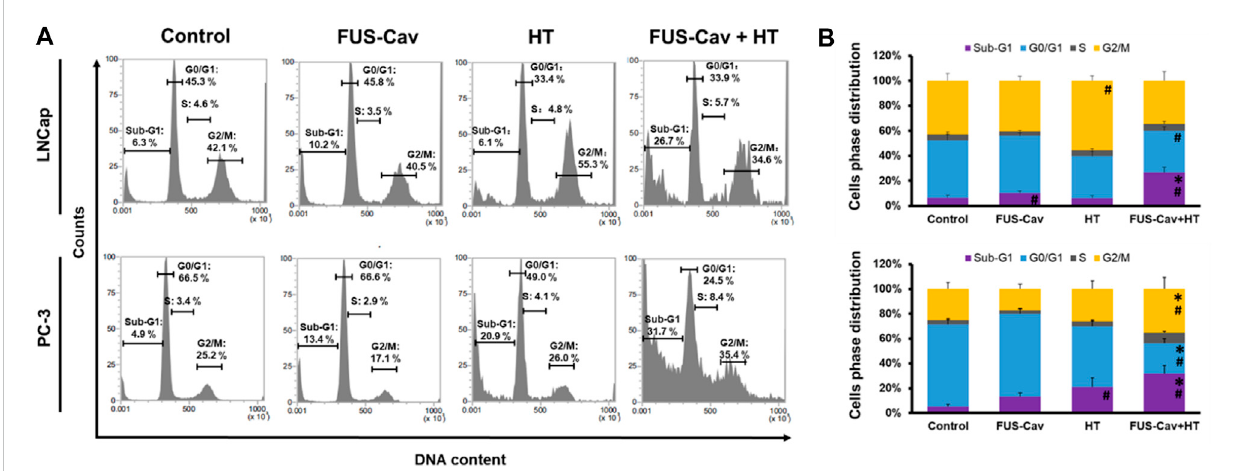
FIGURE 5 The combination of FUS-Cav and HT impacts the cell cycle phase in apoptotic sub-G1 and G2/M. (A) Representative fl ow cytometry results exhibit the percentage of cells in various cell cycles following each treatment. (B) Graphical columns show the cell cycle distribution of LNCap and PC-3 cells 48 h post-treatment. The count of cells in each cell cycle was presented as a percentage of the total cell amount. Data were presented as mean ± SEM, n = 6, *signi fi cantly different from HT ( p ≤ 0.05), #signi fi cantly different from control ( p ≤